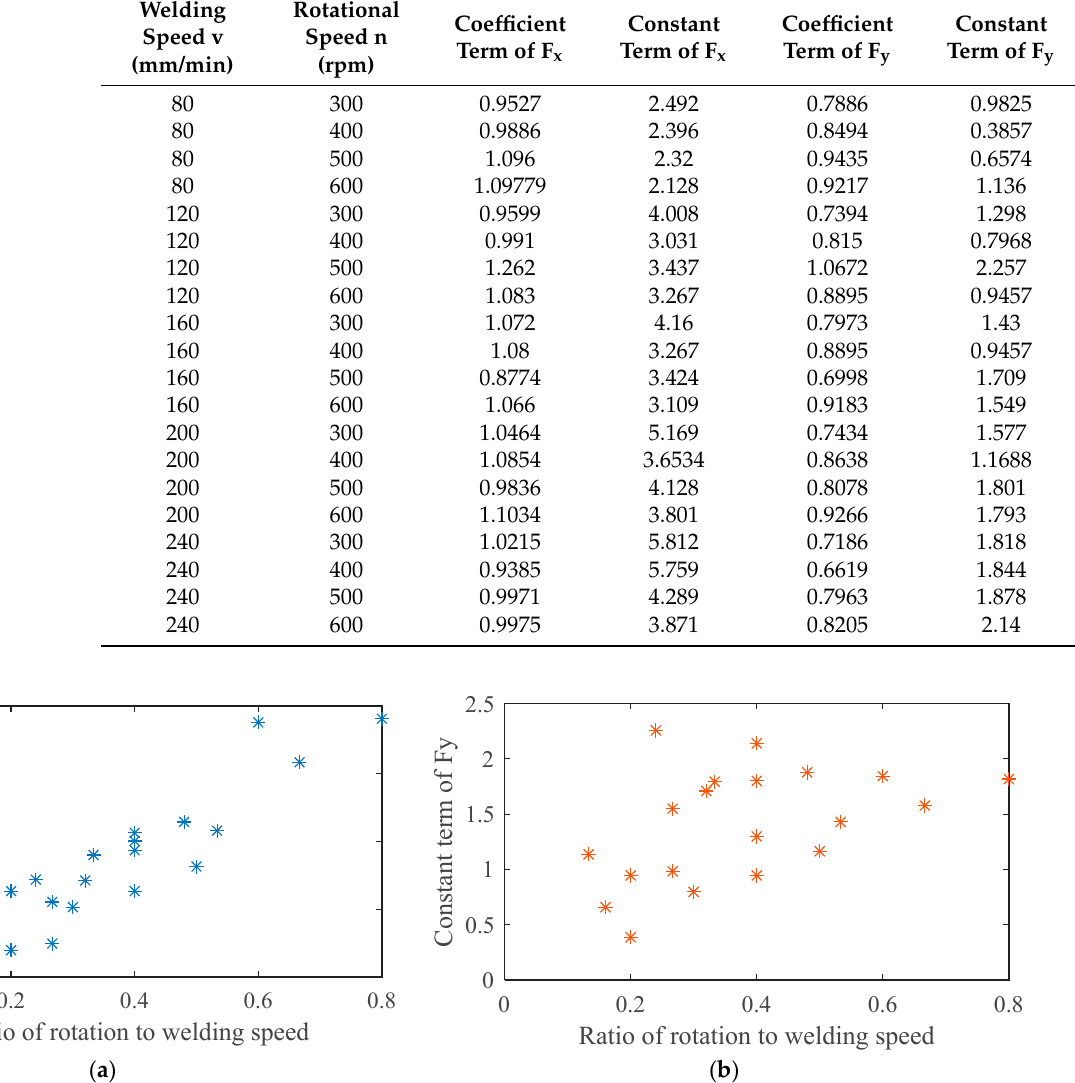
Figure 8. Relationship between constant terms and the ratio of rotational speed to welding speed: ( a ) Fx; ( b ) Fy.